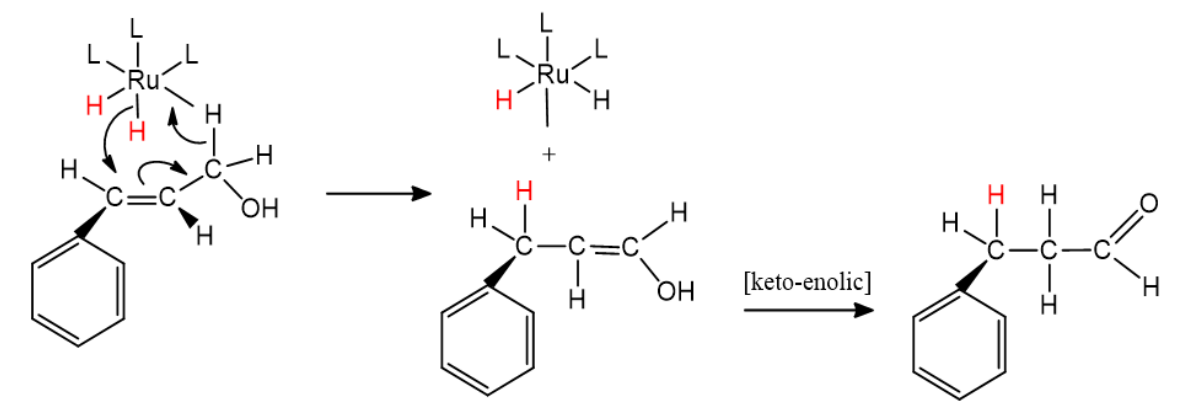
Figure 4. Reaction mechanism for the catalyzed isomerization of cinnamic alcohol to hydrocinnamaldehyde.